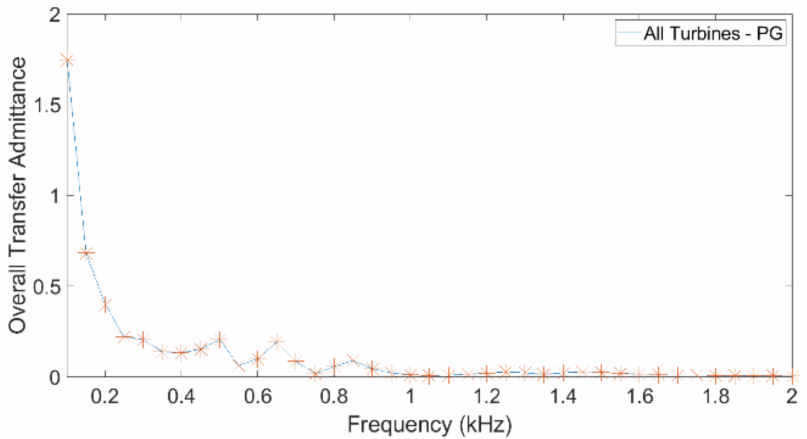
Figure 3. Overall transfer admittance (A/V) from turbine to public grid: 5-turbine plant.